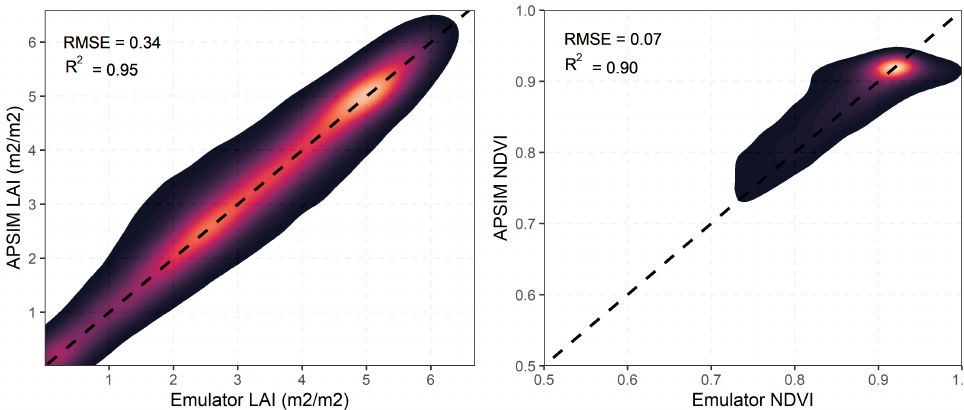
Figure 5. Density plots comparing emulator and APSIM estimates of LAI and NDVI across calibration sites. The lighter colors represent higher density of points and darker color represent lower density of